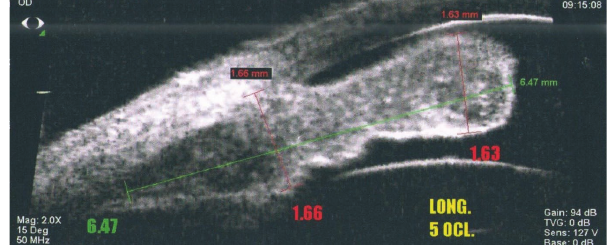
Figure 3. High resolution ultrasound biomicroscope shows diffuse thickening and infiltration of iris with the tumor.